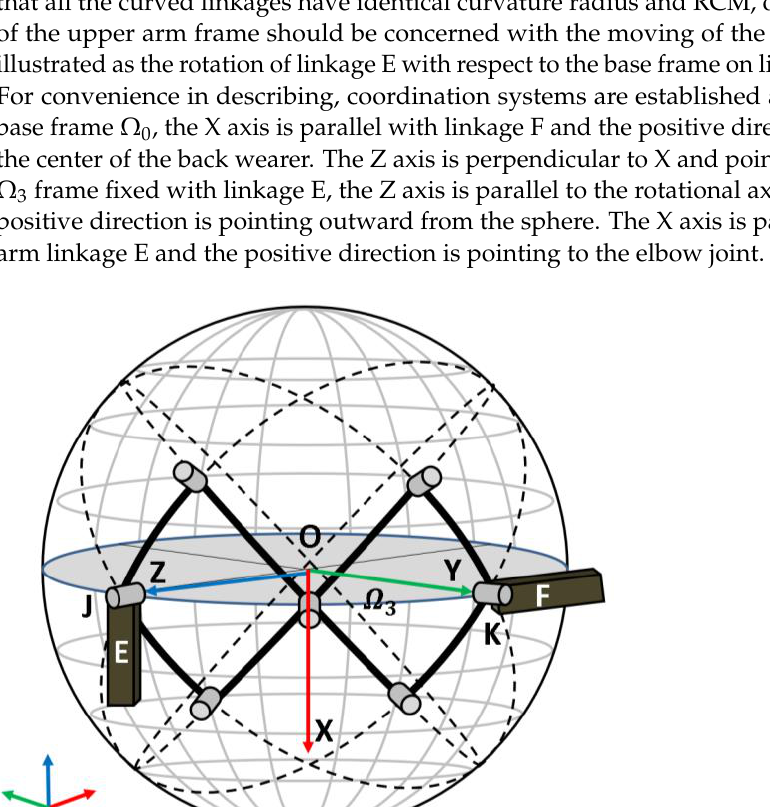
Figure 6. Wearing demonstration of the neutral, lateral limit, and medial limit state of the prototype development.